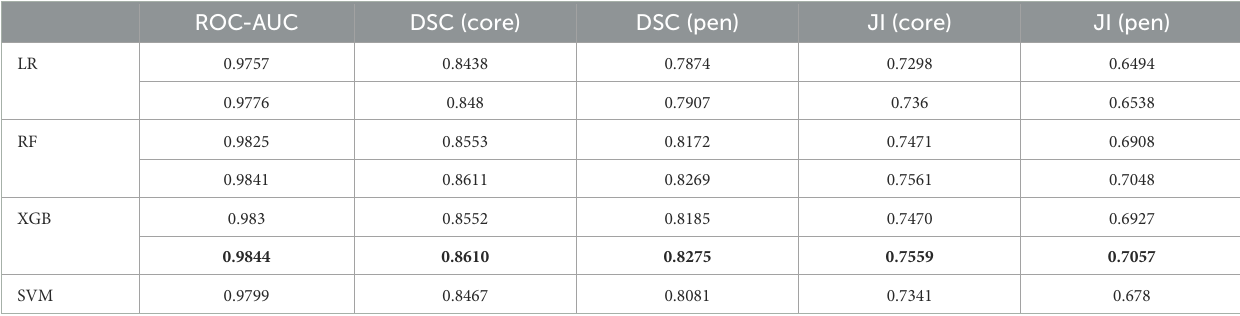
TABLE 3 Results of models on validation data.